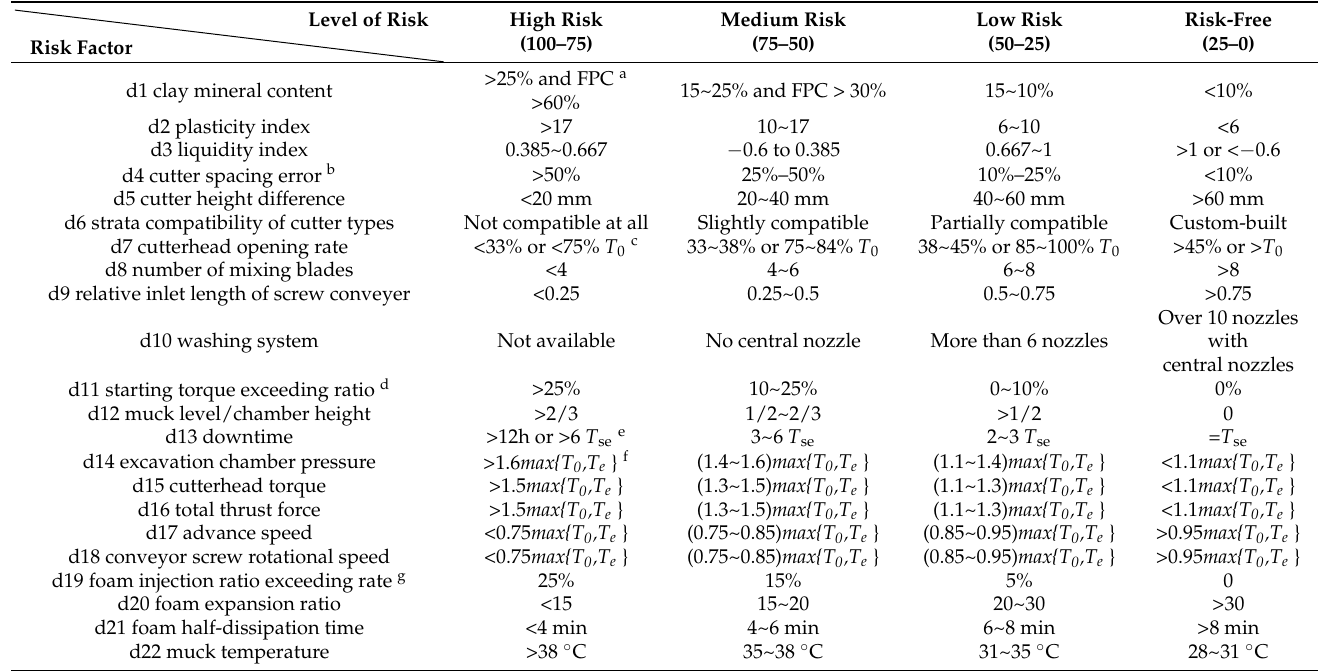
Table 1. Rubric for risk level